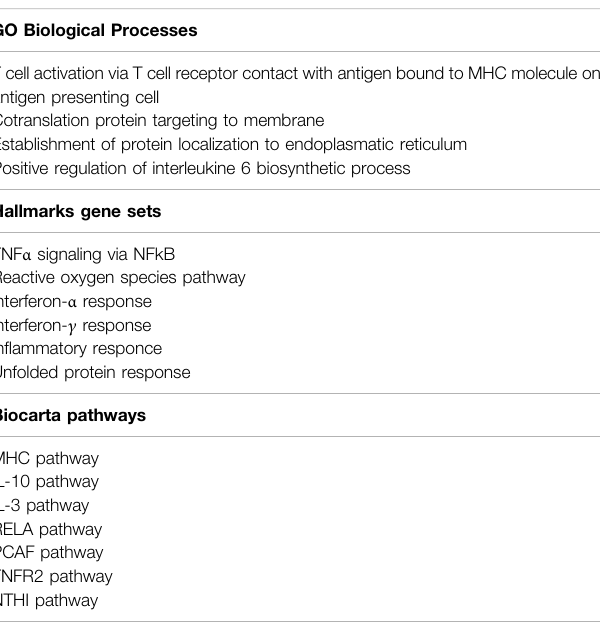
TABLE 1 | Common GO biological processes, Hallmarks and Biocarta pathways within the top ten enriched pathways for spontaneous sputum and induced